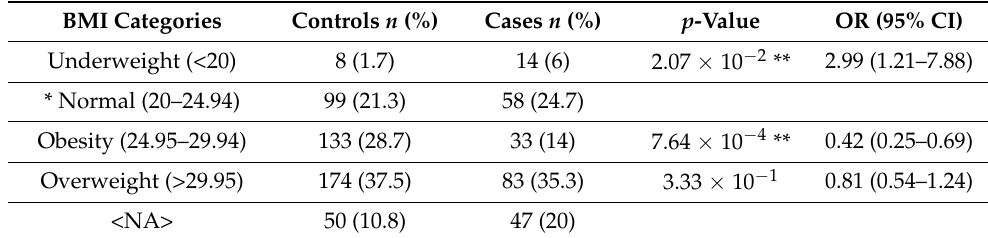
Table 5. ORs, 95% CI, and distribution of cases and controls in BMI quartiles before imputation.